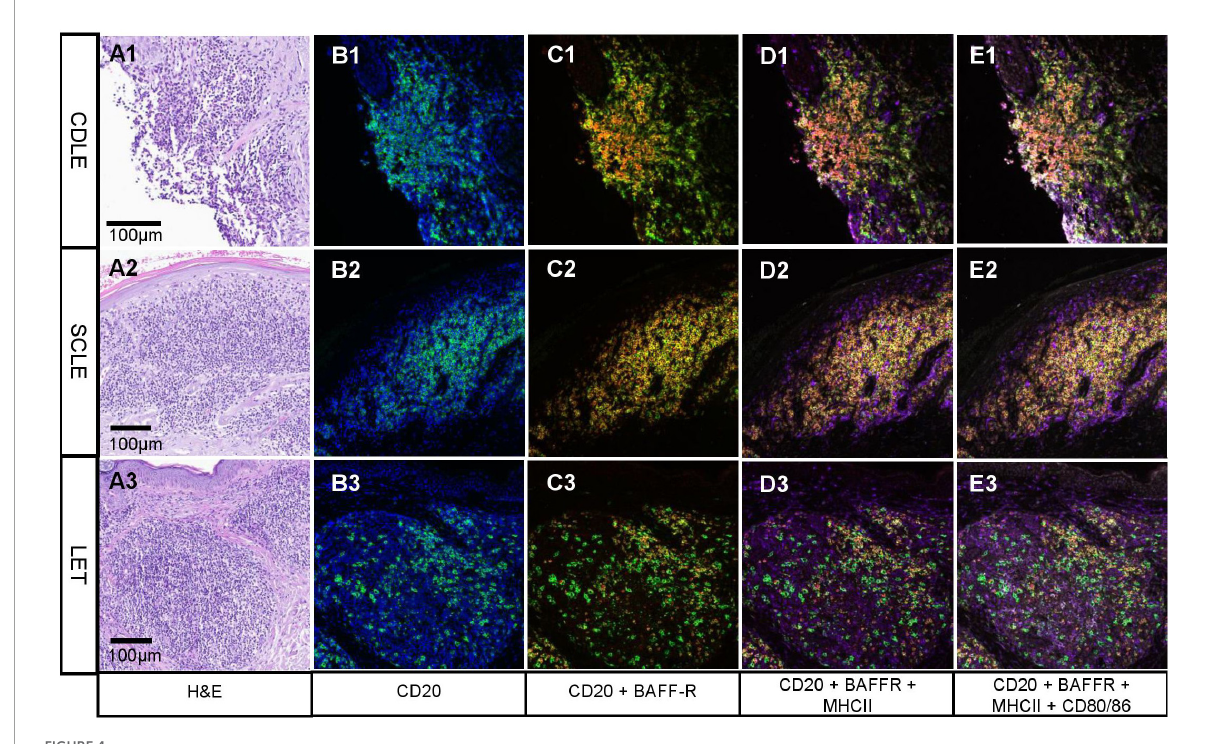
FIGURE4 Fluorescent multiplex-immunohistochemistry focusing on B cell clusters in different subsets of cutaneous lupus erythematosus (CLE). (A1-3) Hematoxylin and eosin staining showing lesional inflammation in different subtypes of CLE: chronic discoid LE (CDLE) (A1) , subacute cutaneous LE (SCLE) (A2) and LE tumidus (LET) (A3) ; scale bar 0,1 mm. B-E Immunofluorescence pictures from multiplex InSituPlex (ISP) immunohistochemistry of lesional inflammation in CLE. B1-3 cell nuclei are visualized by DAPI in blue and CD20 in green. CD20 (B cells) are localized in dense (e.g., B1 ) or scattered clusters [e.g., (B3) ]. (C1-3) CD20 is visualized in green and BAFF-Receptor (BAFF-R) in red. Yellow represents CD20 and BAFF-R colocalization, which can be observed in most B cells. (D1-3) MHC II is visualized in purple, which is staining the B cells and other immune cell populations around them. (E1-3) CD80/86 is visualized in white, which colocalizes with a portion of the C20+ BAFF-R+ MHC II+ B cells. Pictures shown here were chosen based on strong expression for visualization and therefore do not represent infiltrates of the